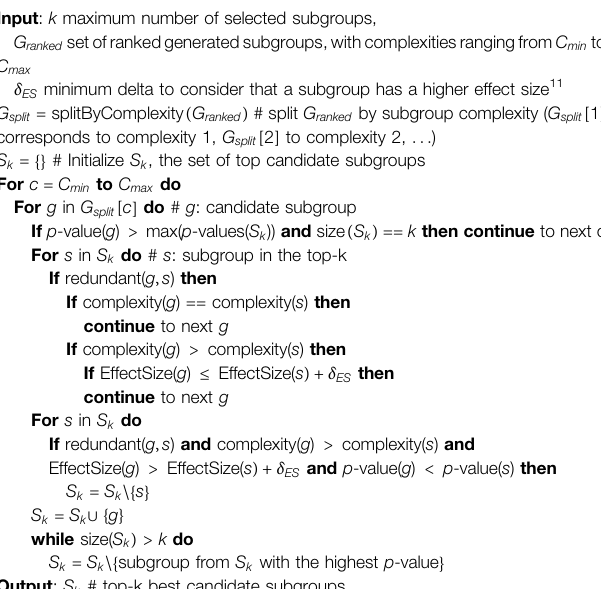
Algorithm 3 Q-Finder ’ s iterative top-k selection based on subgroups ’